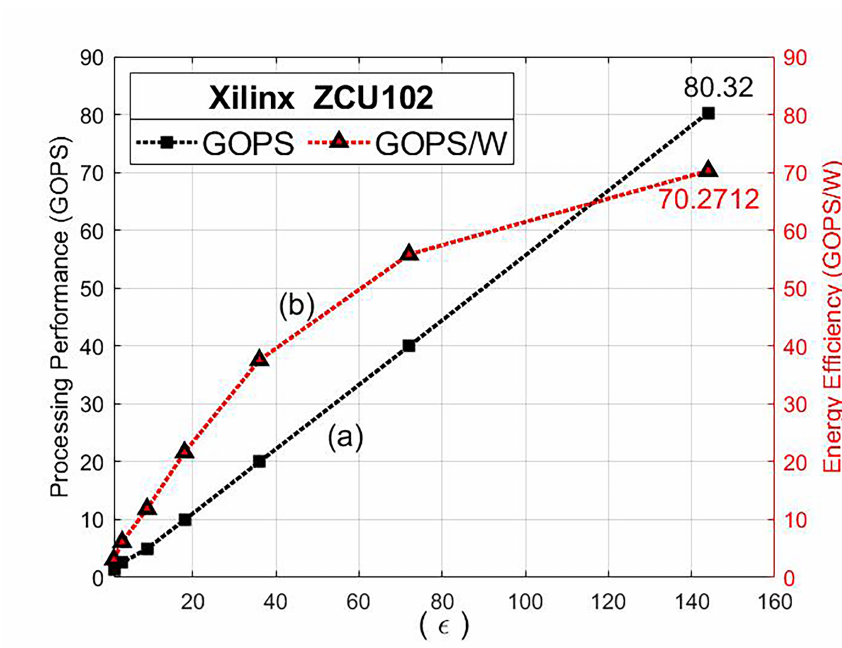
Figure 12. Characterization of performance vs. ε for a PU